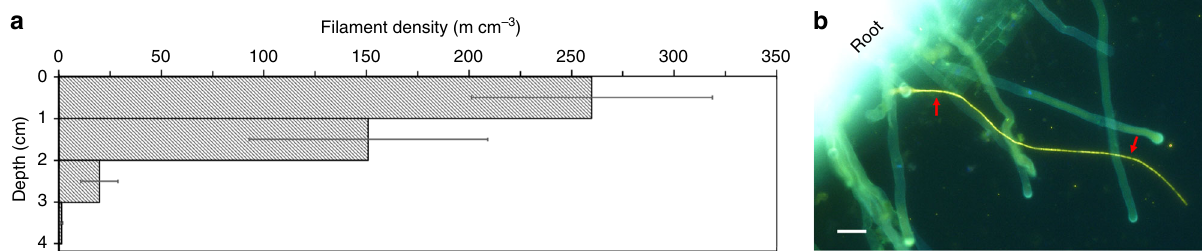
Fig. 1 Distribution of cable bacteria in rice-vegetated pots. a Depth pro fi le of the cable bacteria fi lament densities in inoculated rice soils. Data are presented as mean ± standard error of the mean ( n = 4). b Micrograph of a cable bacteria fi lament in close contact with a rice root. Image from DAPI staining (blue) was superimposed with FISH images hybridized with probe DSB706 speci fi c for Desulfobulbaceae labeled with Cy3 (red) and probe EUB- MIX targeting most bacteria labeled with Atto-488 (green). Red arrows point to the cable bacteria fi lament. Scale bar, 20 µ